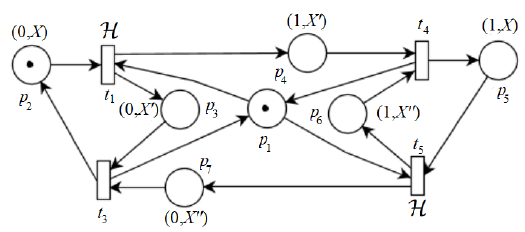
Figure 10. QPN of oriented QDRW on a